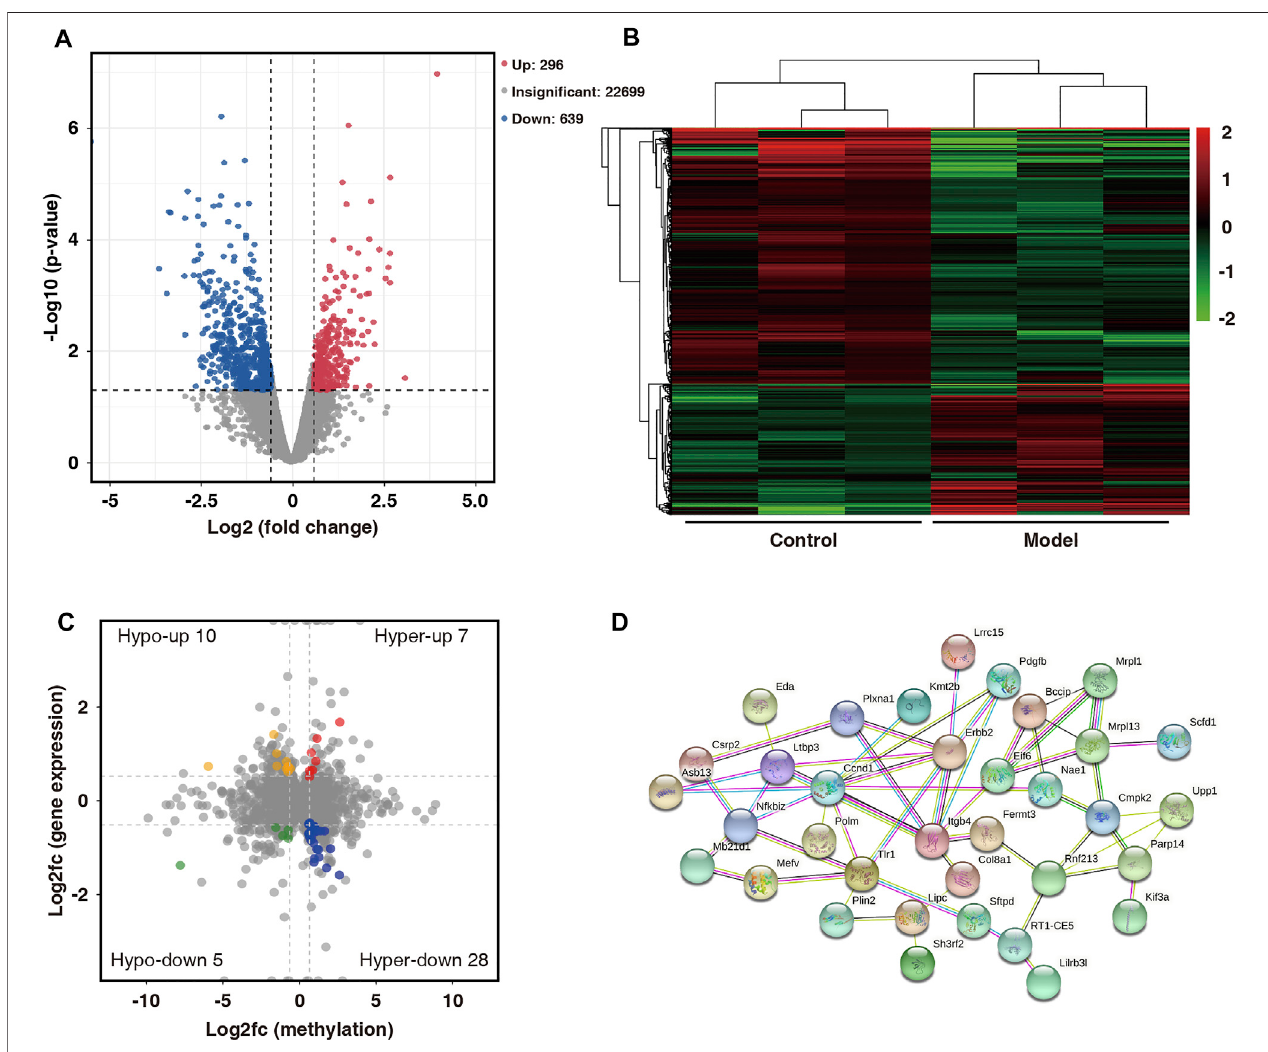
FIGURE 6 | Combined analysis of MeRIP-seq and RNA-seq data for control and model group. (A) Distribution of differentially expressed mRNAs in control and model groups (fold change ≥ 1.5 and p < 0.05). (B) Hierarchical clustering analysis of differentially expressed mRNAs. (C) Differentially modi fi ed and differentially expressed genes ( “ double aberrant genes ” ) in control and model groups (fold change ≥ 1.5 and p < 0.05). (D) PPI network analysis of 50 double aberrant